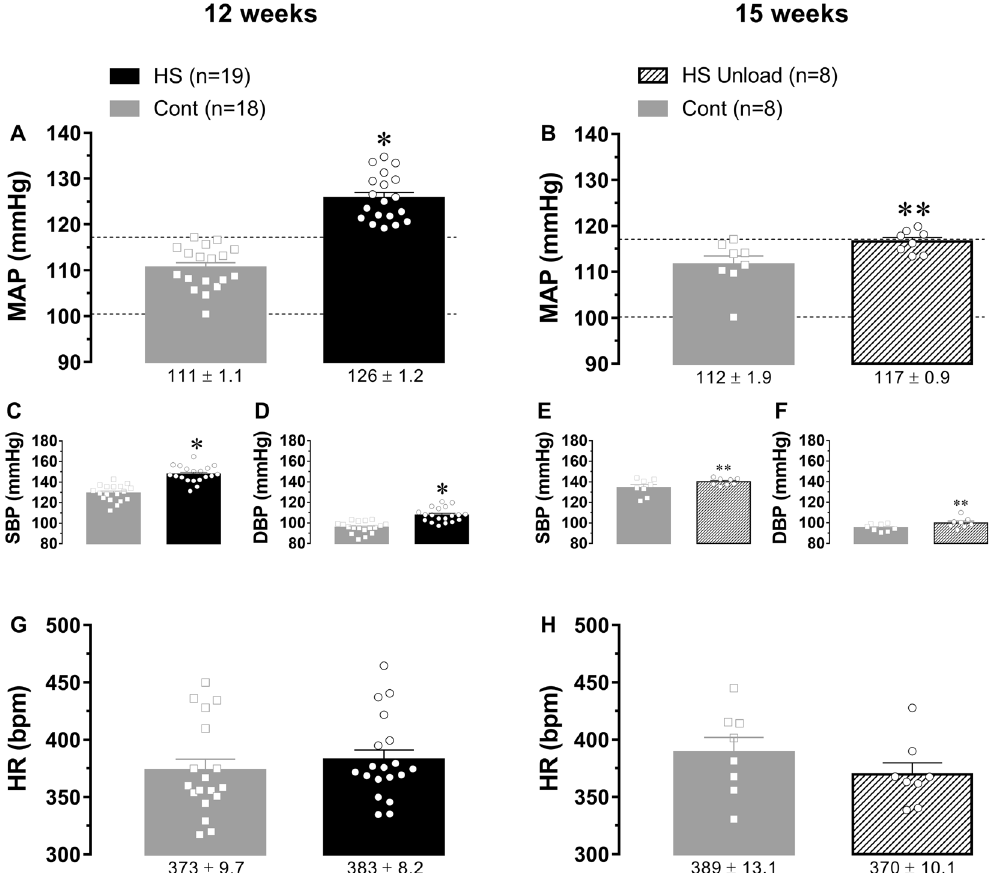
Figure 2. Baseline levels of mean arterial blood pressure (MAP) and heart rate (HR) in rats from HS, HS Unload and respective control groups. Direct measurements of MAP and HR were performed on the 12 th and 15 th weeks after weaning. Scattered squares (Cont) and circles (HS/HS Unload) represent individual values and bars represent average group data. Average mean ± SEM are indicated under the bottom of respective bars. Horizontal dashed lines define the boundaries for control MAP and HR range. Systolic blood pressure (SBP) and diastolic blood pressure (DBP) for all groups are shown in the smaller panels (C through F). * Different of control group; one way ANOVA followed by Bonferroni’s post-test; ** different of HS group; one way ANOVA followed by Bonferroni’s post-test; p <